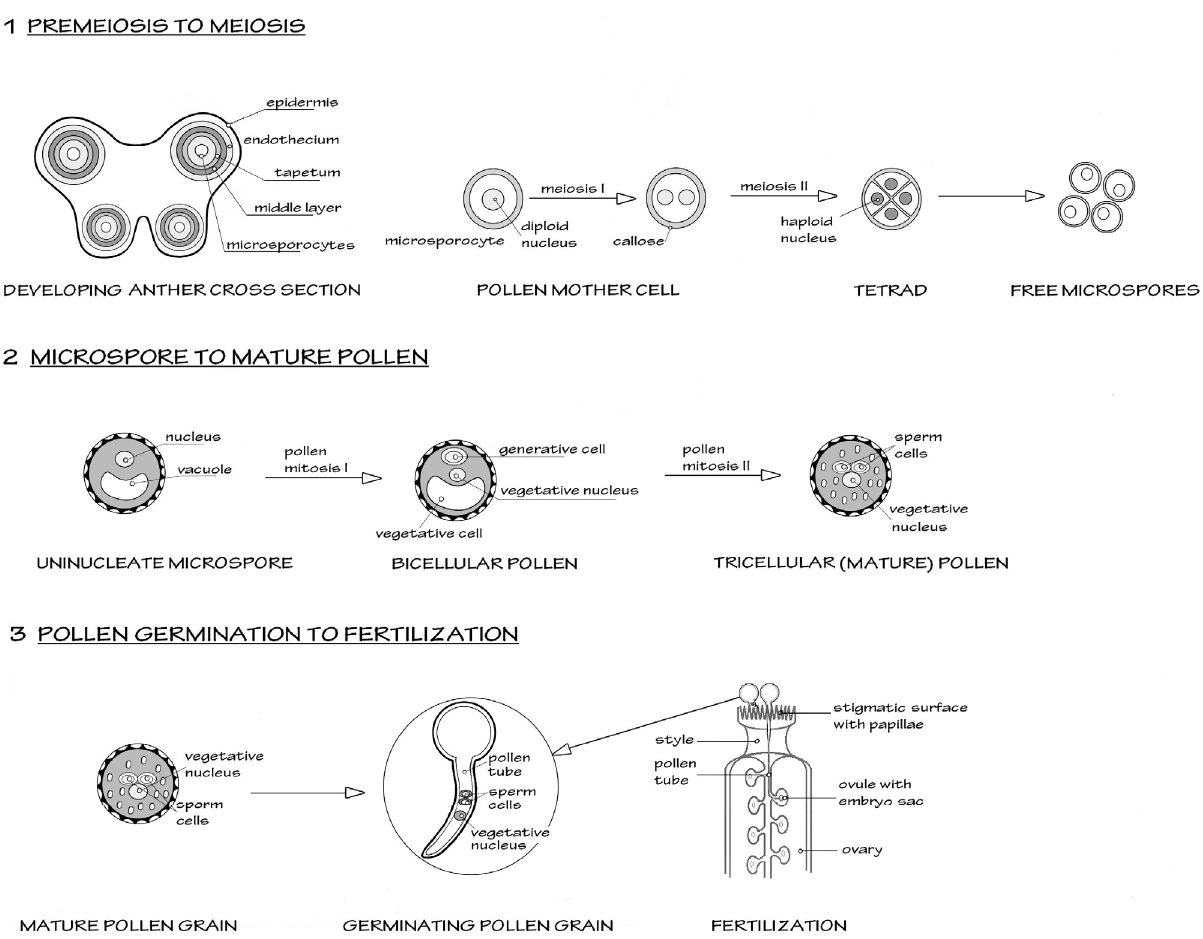
Figure 1. Scheme to show the three major stages in male reproductive development in flowering plants, from premeiosis through to fertilization (syngamy). The model organism Arabidopsis thaliana is taken as the basis for this simplified scheme. Section 1 shows the events in the early anther development, where diploid microsporocytes undergo meiosis to form four haploid microspores, the first stage of male gametophyte development. All four microspores survive and further differentiate as shown in Section 2. Two mitotic events occur. The first mitosis (pollen mitosis I) is highly asymmetric and forms a larger vegetative cell and a smaller generative cell. The generative cell then undergoes pollen mitosis II, to form a pair of sperm cells suspended in the vegetative cell cytoplasm. After this mitosis, the pollen undertakes programmed dehydration and is released from the anther. Section 3 shows the events after the pollen grain alights on a suitable receptive stigma. The pollen grain rapidly hydrates and initiates a new phase of growth as the vegetative cell forms a pollen tube. The rapid tip-based growth of the pollen tube penetrates the stigmatic surface and then grows through the tissue of the style towards the ovary. The pollen tubes are attracted to the ovules containing the embryo sac (the female gametophyte). As the pollen tube enters the ovule, it bursts to liberate the two sperm cells. One sperm will form the diploid zygote after fusing with the egg cell. The other sperm initiates triploid endosperm formation after fusing with the nuclei of the central